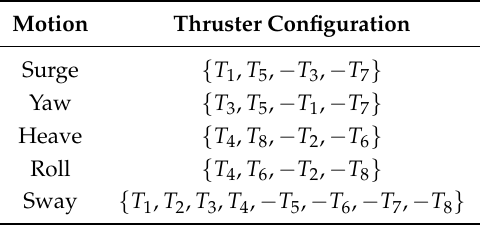
Table 1. Actuator Configuration for Spherical